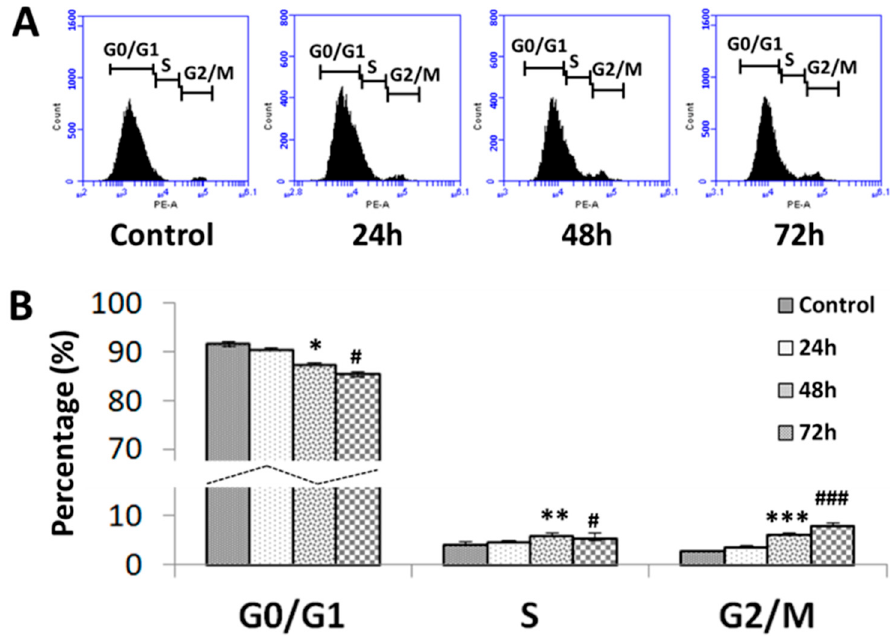
Figure 3. Cycle progression of HepG2 cells over the time of SFA-CHCl3 extract treatment. ( A ) Flow cytometry was applied to analyze the cell cycle progression. ( B ) The calculation of percentage of HepG2 cells in cell cycle phases. The percentage of HepG2 cells in G0/G1 phase was reduced from 24 h to 72 h (* p < 0.05, 48 h group vs. other groups; # p < 0.05, 72 h group vs. other groups). The percentage of HepG2 cells in S phase was slightly increased in 48 h and 72 h (** p < 0.01, 48 h group vs. control group and 24 h group; # p < 0.05, 72 h group vs. control group and 24 h group). The percentage of HepG2 cells in G2/M phase was increased in 48 h and 72 h (*** p < 0.001, 48 h group vs. other groups; ### p < 0.001, 72 h group vs. other groups).